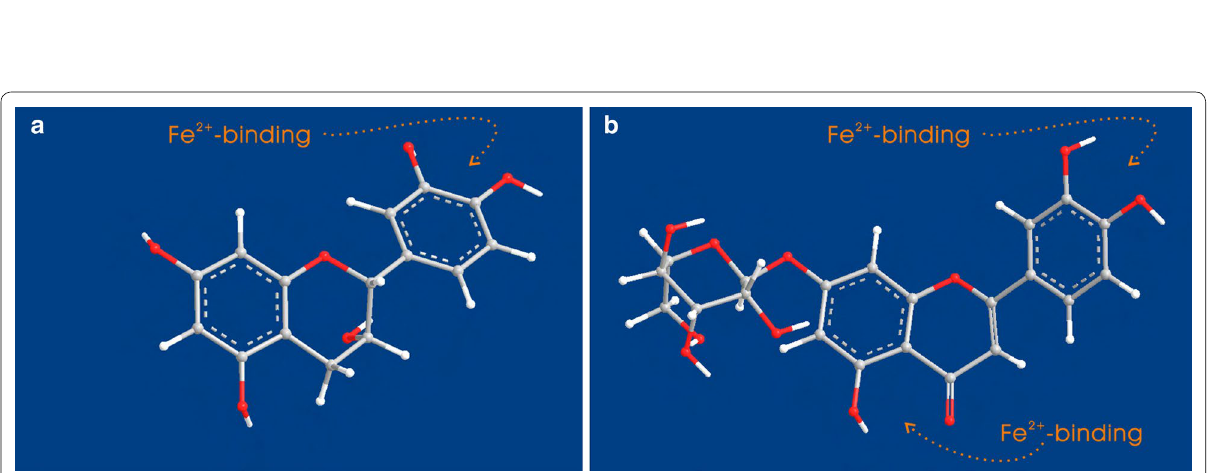
Fig. 4 UV spectra of LAS, epicatechin, and luteolin-7- O - β -D-glucoside and their binding products with excess Fe 2 + (the inset figure is the appear- ances of solutions; LAS lyophilized aqueous extract of Suoyang )